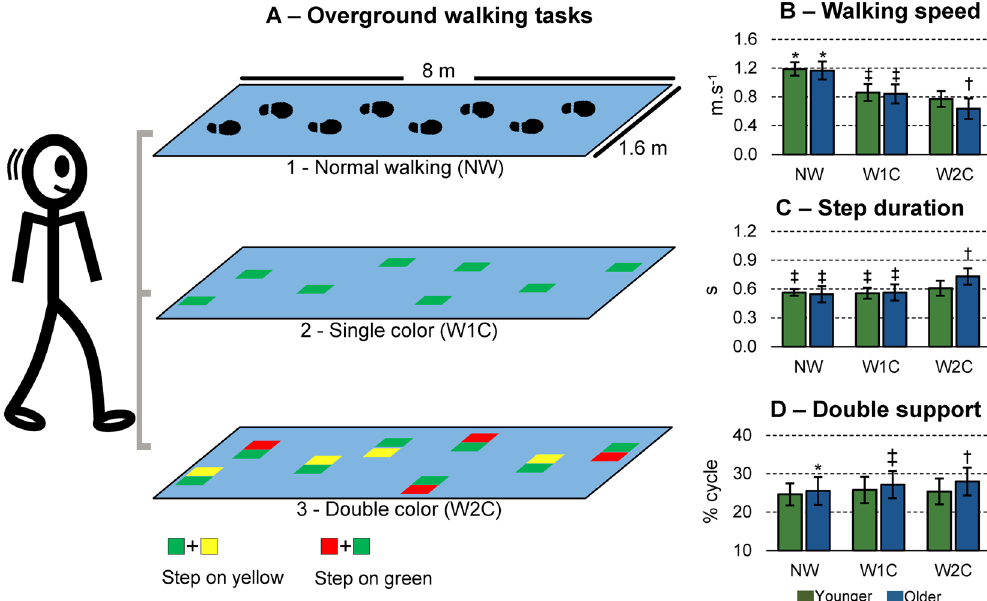
Figure 3. Overground walking protocol ( A ). Younger and older adults walked at preferred speed (1, NW), at preferred speed while following pre-established clues on the floor (2, W1C) and at preferred speed while having to step only on the correct color (3, W2C). Participants should step on the yellow clue if the pair of clues was green + yellow, whereas they should step on the green clue if the pair of clues was red + green. The mean ± SD walking speed ( B ), step duration ( C ) and double support period ( D ) were calculated for each condition. * Denotes significant difference in relation to W1C and W2C (p < 0.05); ‡ Denotes significant difference in relation to W2C (p < 0.05); † Denotes significant group × condition interaction, in which older adults were different in relation to the younger group in W2C (p <